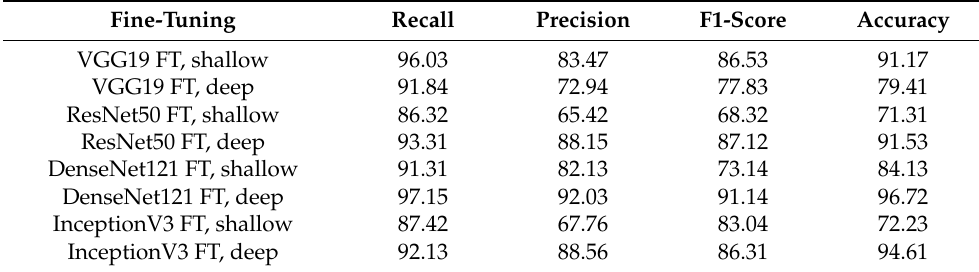
Table 2. The classification performance of the proposed method.